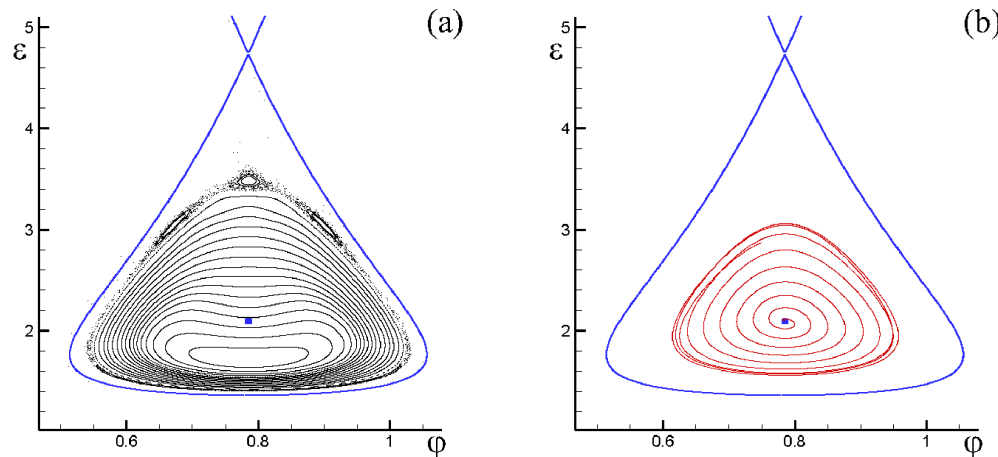
Figure 4. The same as in Fig. 3, except ν = 0 . 3. Panel (a) shows a Poincaré section illustrating that the perturbed system remains largely linear near the steady-state elliptic critical point; (b) a divergent spiralling phase trajectory starting at the steady-state elliptic critical point experiencing linear parametric